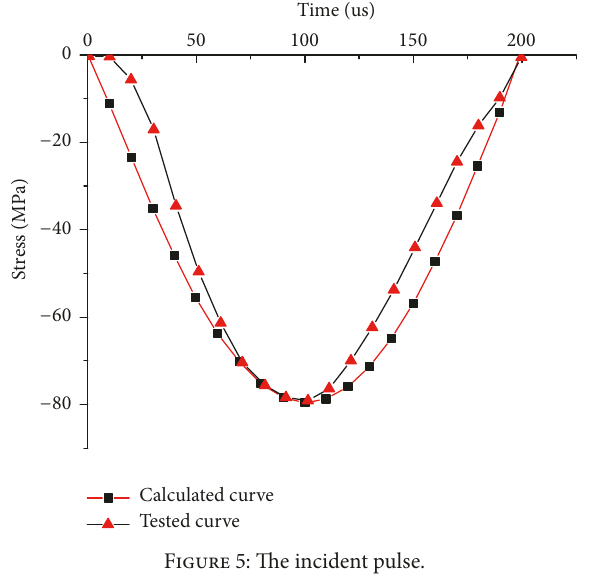
Figure 5: The incident pulse.